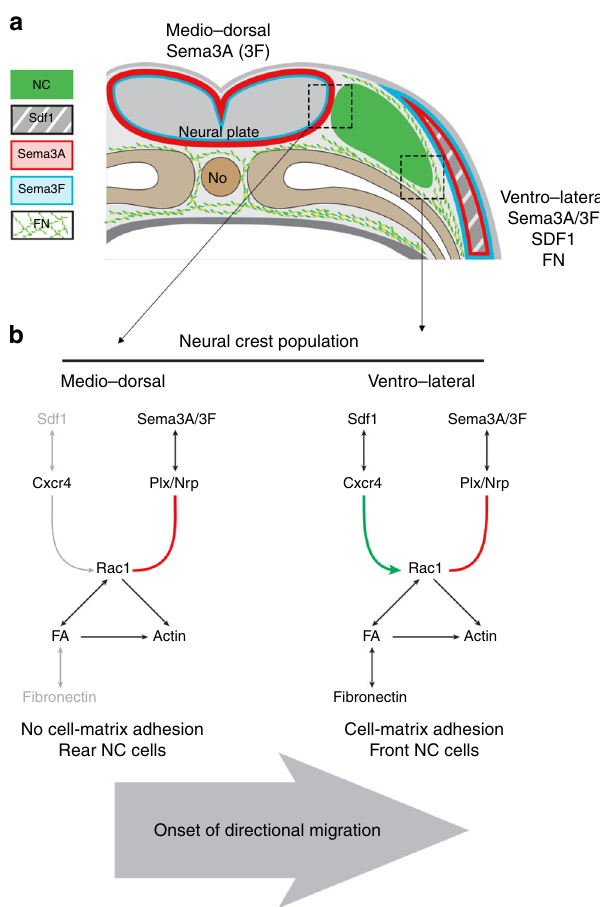
Fig. 10 Model. a Diagram summarising the expression of Sema3A (red), Sema3F (blue), Sdf1 (grey, stripped), and the distribution of Fibronectin (green fi bres) on a transversal section at the onset of NC cell migration (NC cells are in green). b Diagram of the proposed signalling events taking place. Sdf1 activates Rac1 whereas Sema3A inhibits Rac1. Medio-dorsally, Fibronectin and Sdf1 are lacking. Thus, the effect of Sema3A on Rac1 dominate and NC cells cannot adhere to the matrix. Ventro-medially, all players are present. Sdf1 counterbalances Sema3A, NC cells can adhere